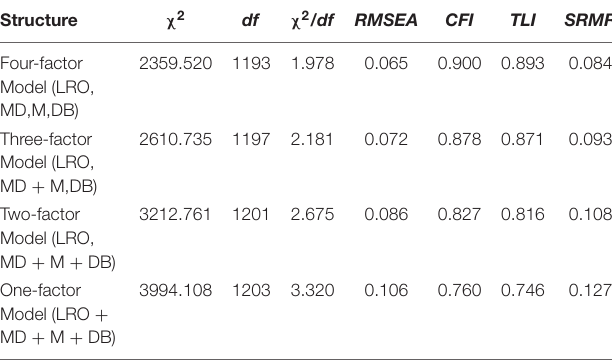
TABLE 2 | Summary of model fit